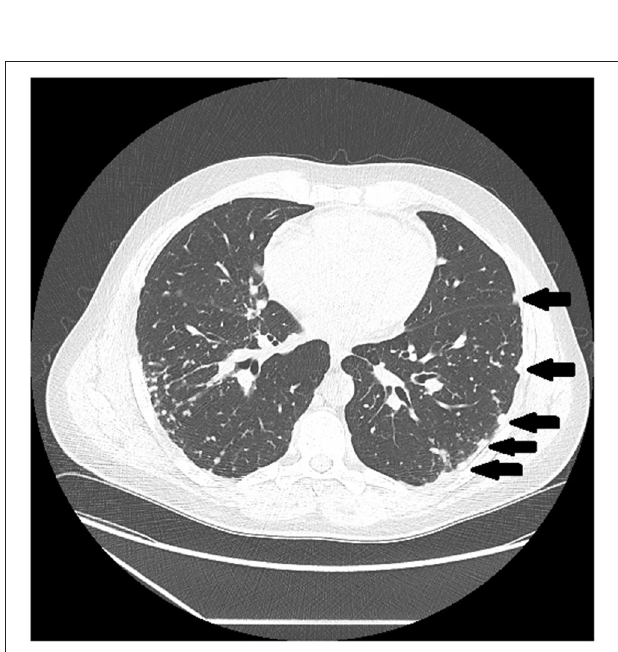
FIGURE 2 | Chest CT scan showing multiple subpleural nodules from sarcoidosis (arrows).